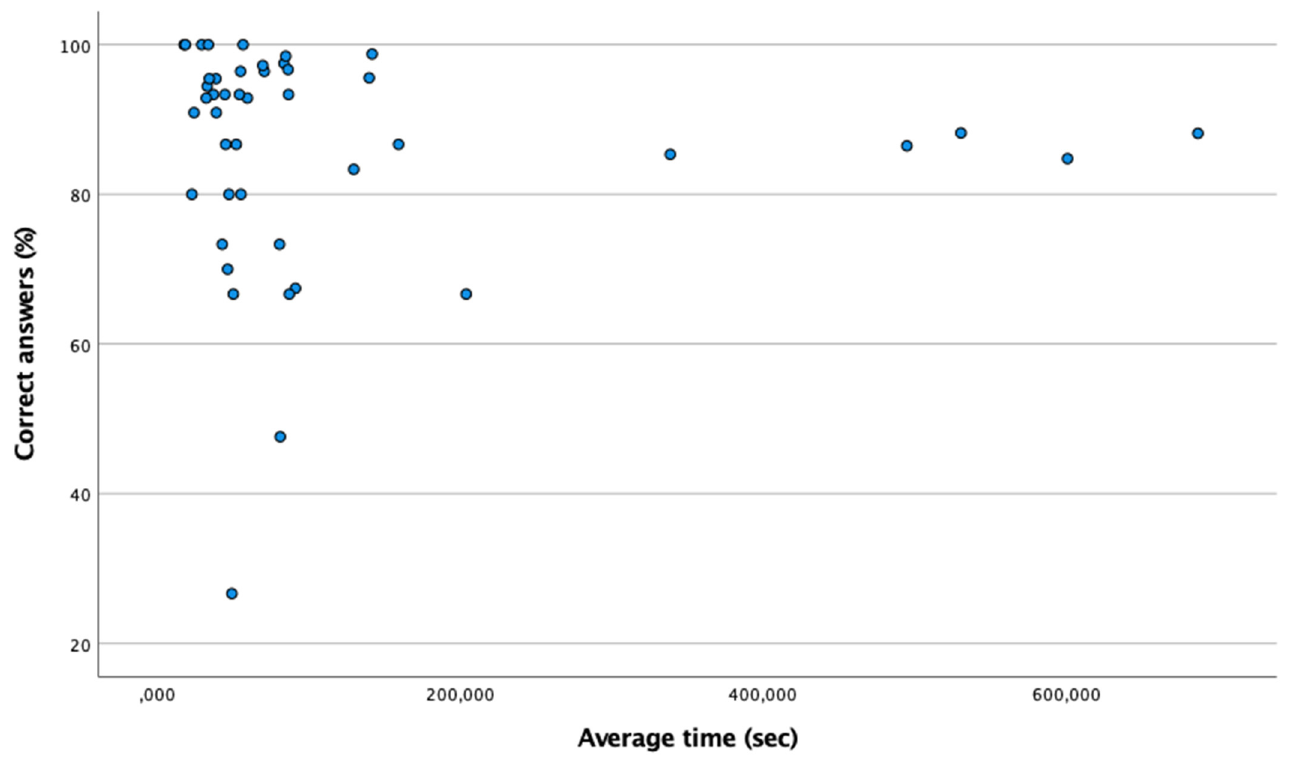
Figure 7. Absence of relationship between the percentage of correct answers and the mean time in the visual memory test.